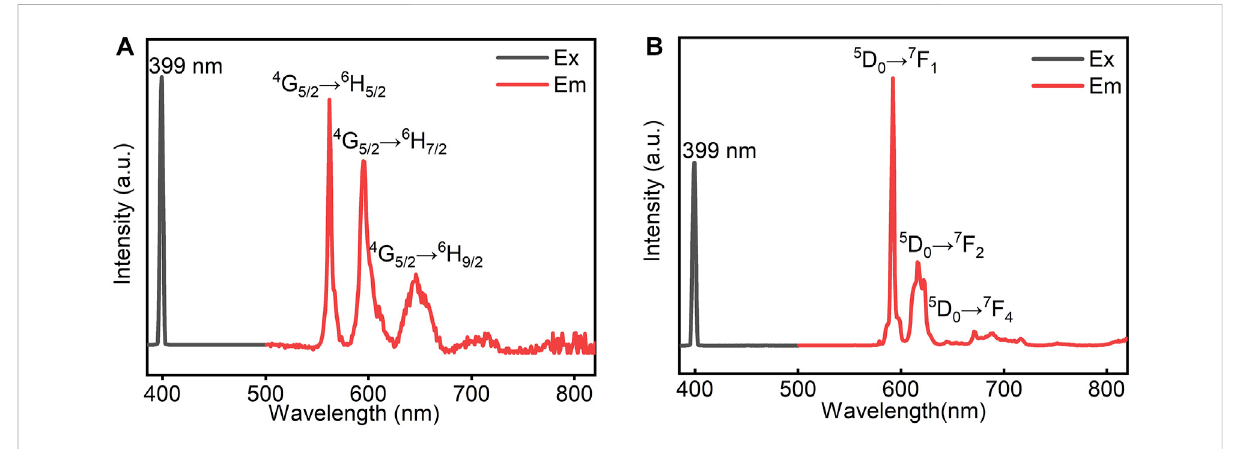
FIGURE 5 Excitation spectra and emission spectra of 1 (A) and 2 (B) .